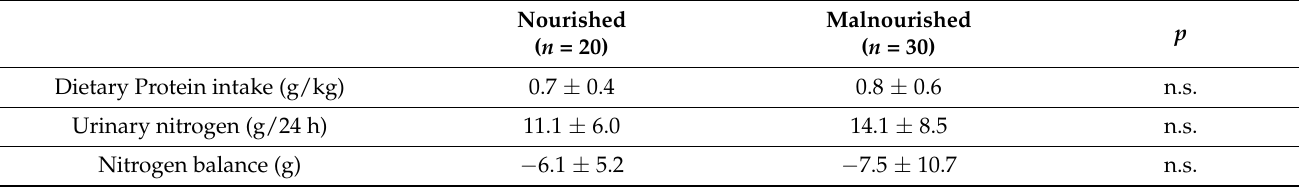
Table 3. Protein intake, urinary nitrogen excretion and nitrogen balance in cirrhotic patients divided by nutritional status (malnutrition defined for MAMC <5 ◦